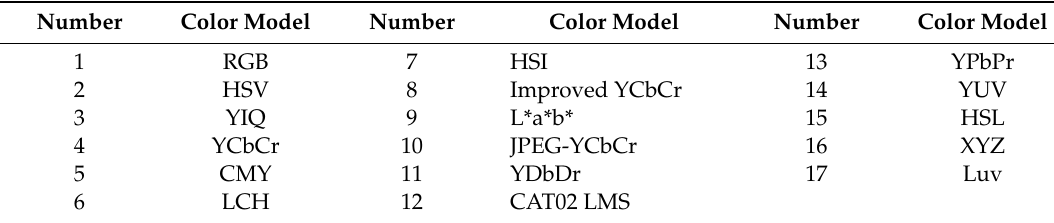
Table 2. Various color models